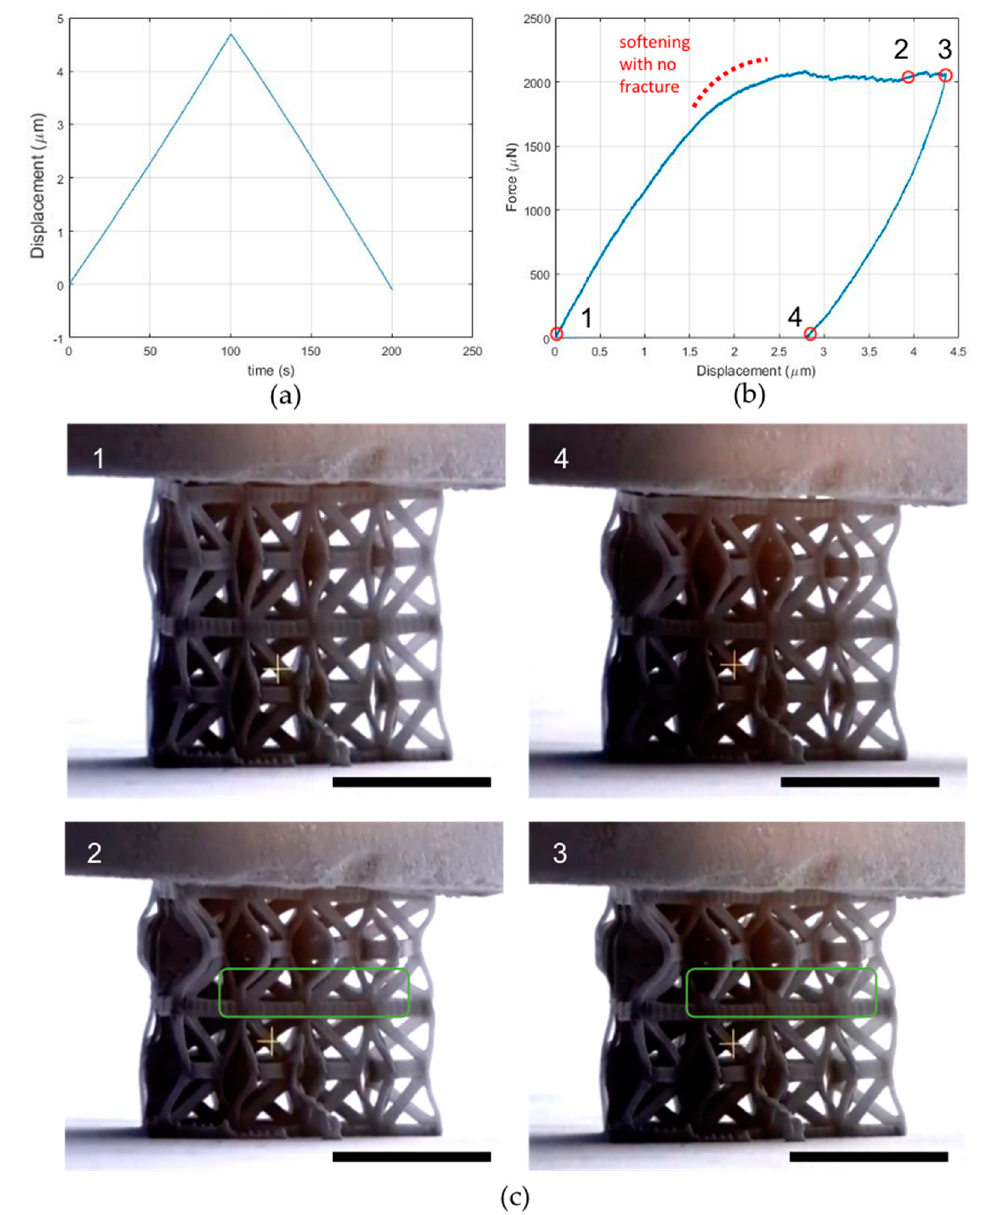
Figure 8. Mechanical testing on a twenty-unit two-layer array. ( a ) Imposed displacement–time and ( b ) force-displacement plots. ( c ) Snapshots of the sample during testing (cf. Video S4: Twenty-unit two-layer array). Some fracturing beams are enclosed in the green rectangle The black scale bar for each SEM figure is 10 μ m.